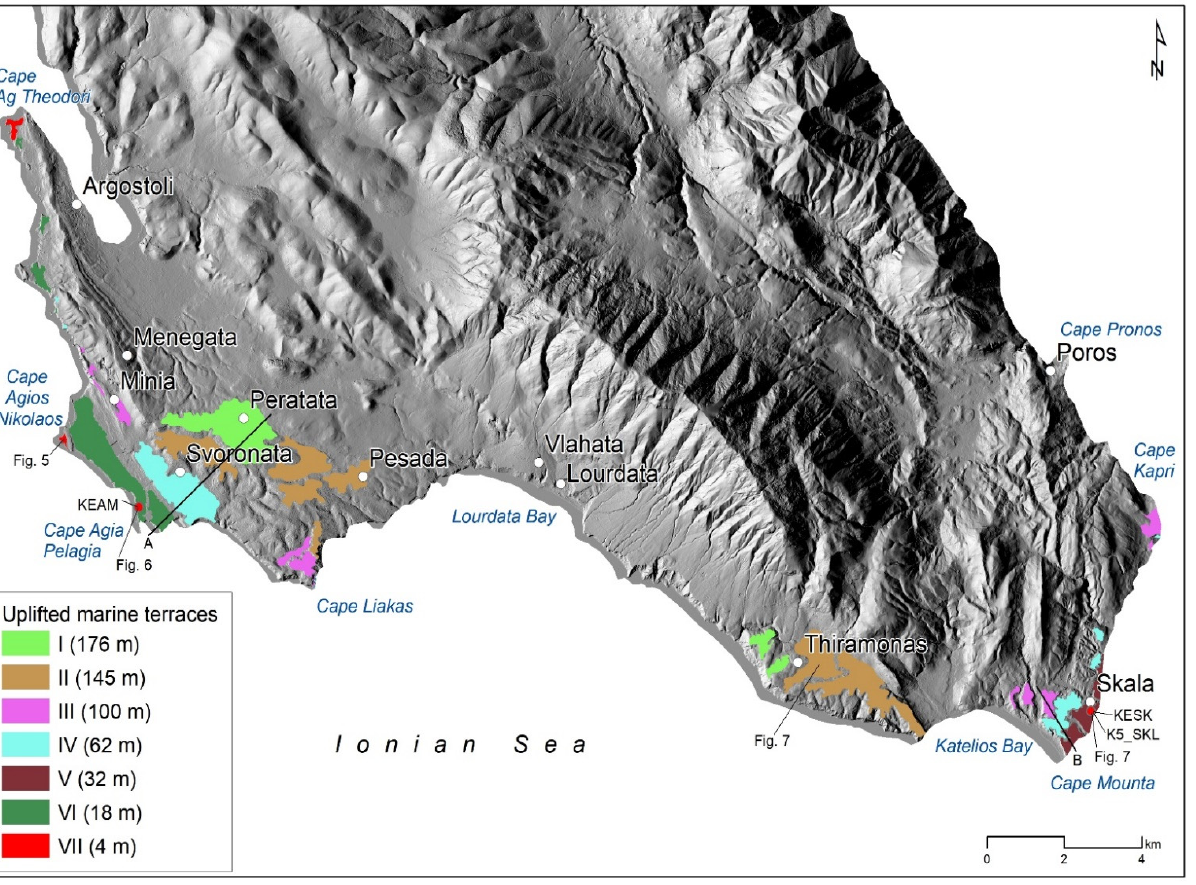
Figure 4. Spatial distribution of the prominent uplifted marine terraces which have evolved mainly on Plio–Pleistocene formations. Their lateral continuity is disturbed by the fluvial action of many ephemeral streams. ephemeral